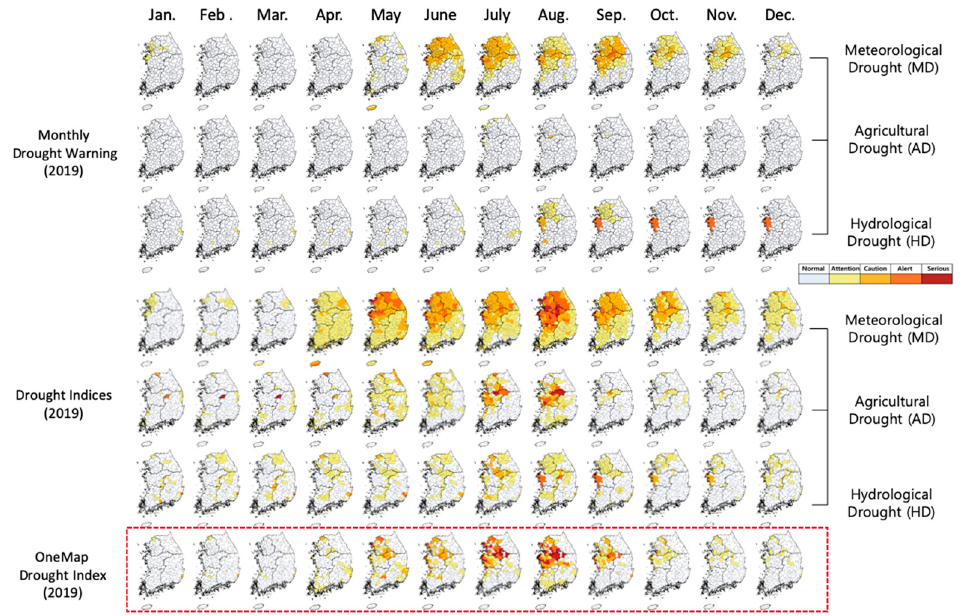
Figure 8. Evaluation and analysis of the OneMap drought index drought based on ground data (2019 drought forecast and warning operation information).